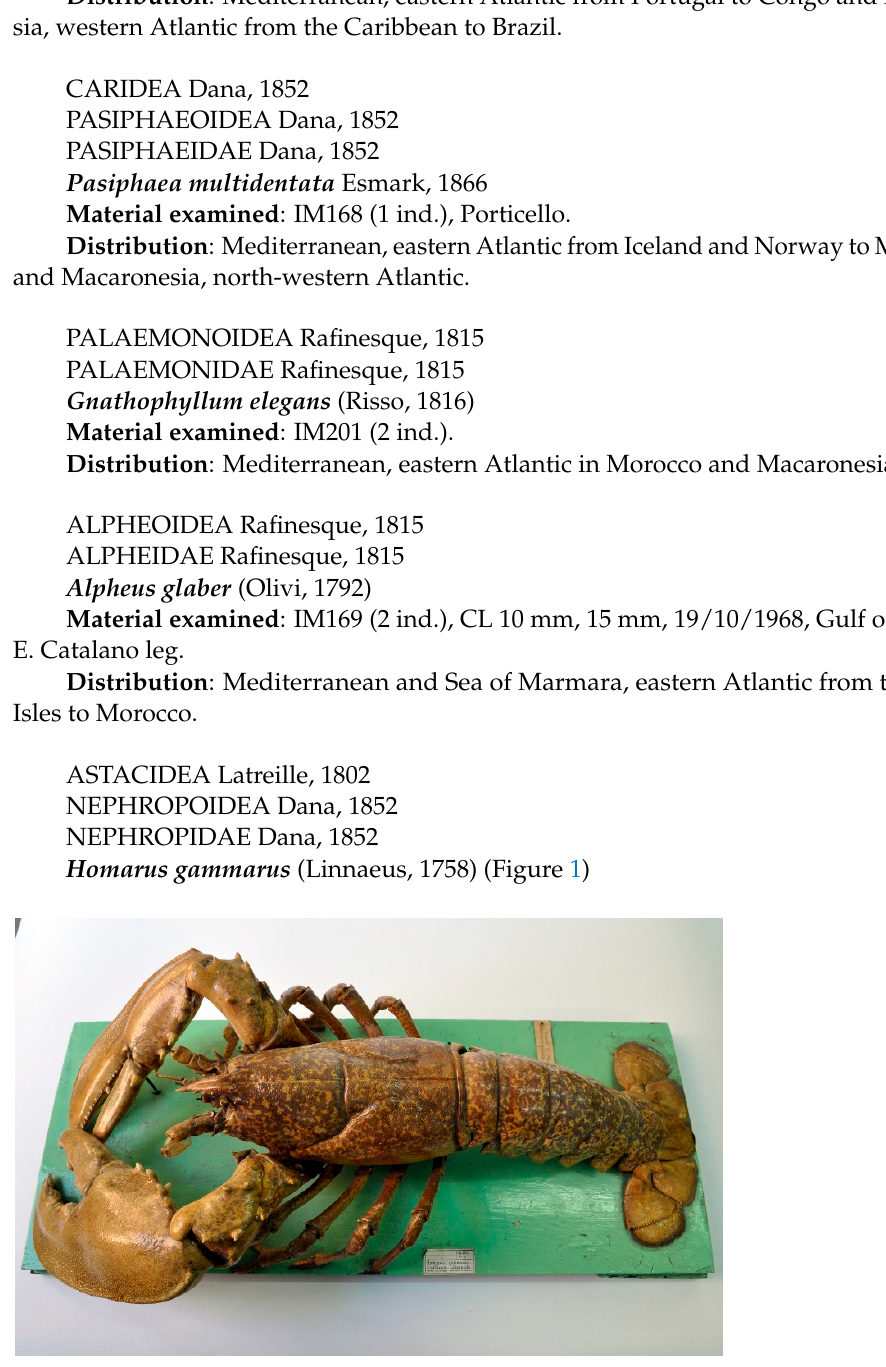
Figure 1. Homarus gammarus